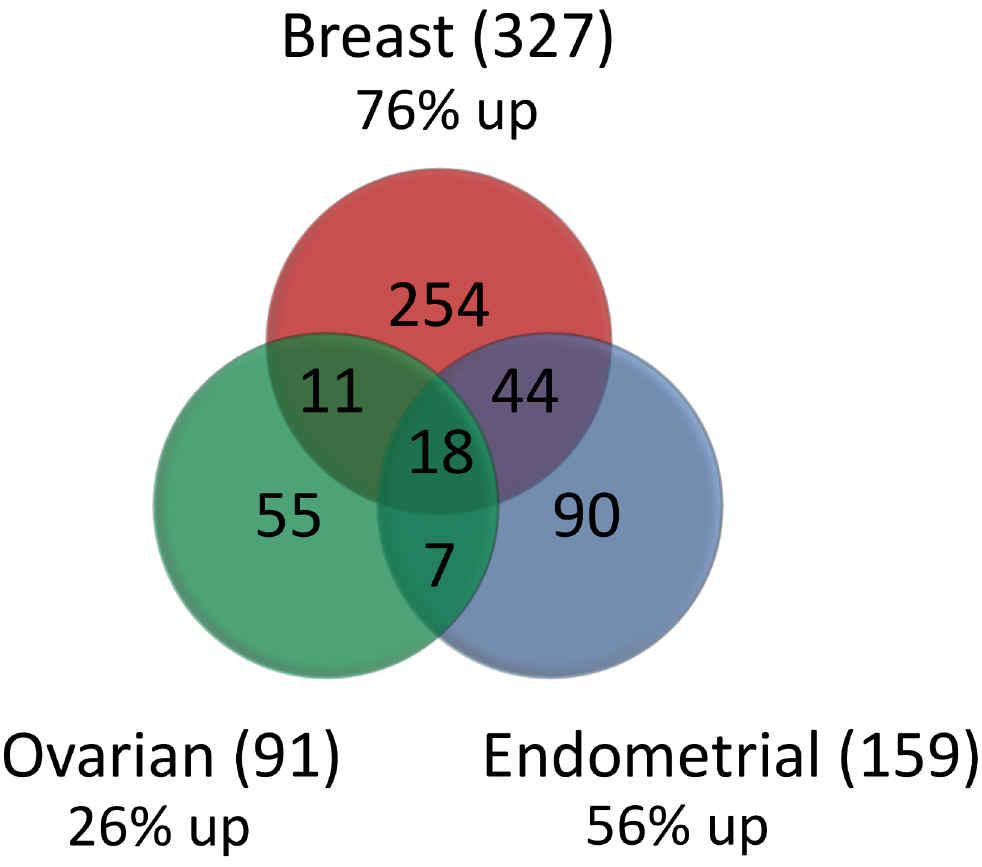
Figure 1. Overlap among gene signatures for the 3 cancer panels. We identified sets of genes with significantly altered gene expression profiles between eribulin and paclitaxel treatments for breast, ovarian, and endometrial cancer. The signature consisted of 327, 91, and 159 genes for breast, ovarian, and endometrial cancer, respectively. The percentage of genes having higher expression in cell lines treated with eribulin compared to paclitaxel is 76%, 56%, and 26% for breast, endometrial, and ovarian cancer, respectively. doi:10.1371/journal.pone.0106131.g001 PLOS ONE |